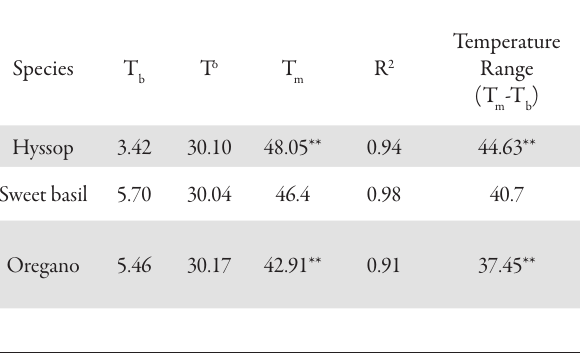
Tab. 2. Cardinal temperatures (°C) of hyssop, sweet basil and oregano on the segmented